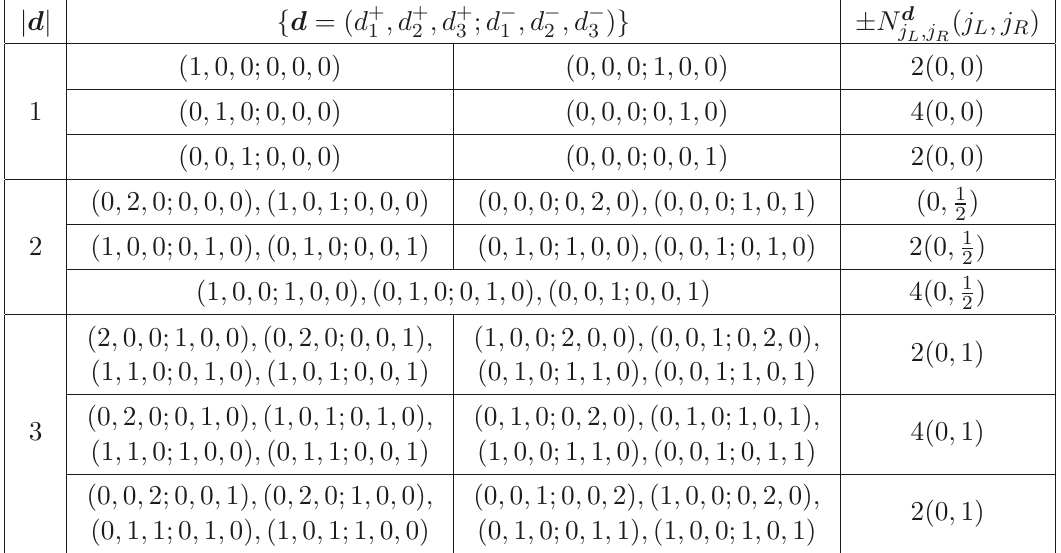
Table 2 . The BPS indices N d identified for the (2 , 2) model under the assumption of six K¨ahler j L ,j R parameters. Here N d ( j L , j R ) on the top of the right column stands for the abbreviation of j L ,j R ± ( 1) | d |− −